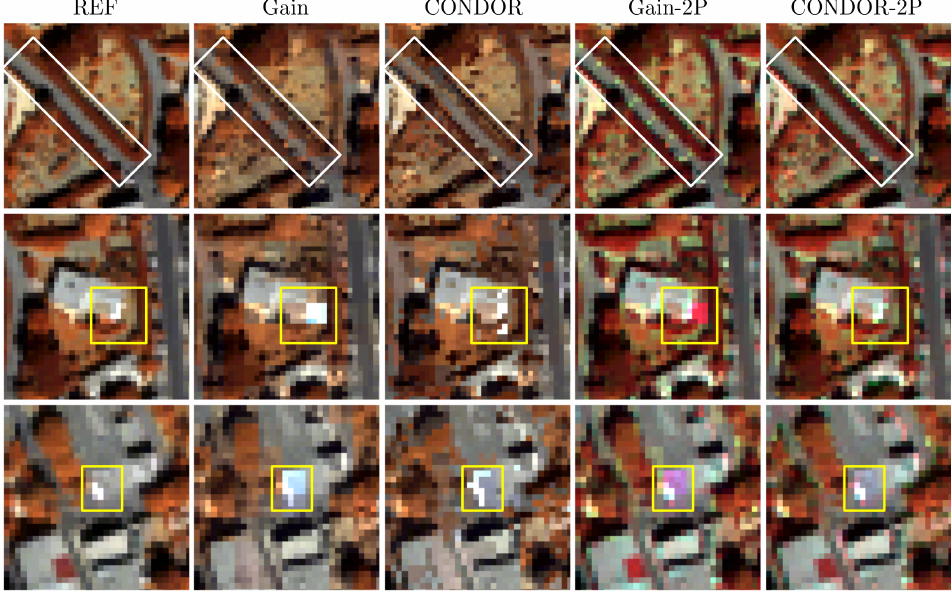
Figure 15. “Gardanne” urban dataset: local visual results (SWIR colour composite images; spatial resolution: 1.5